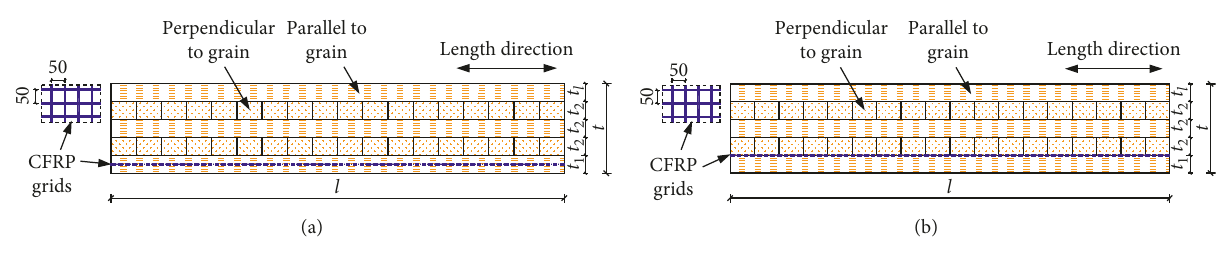
Figure 10: Details of one-way CLB slabs strengthened with CFRP grids: (a) CLB-I and (b) CLB-M. Table 4: Dimensions of one-way CLB slabs strengthened with CFRP